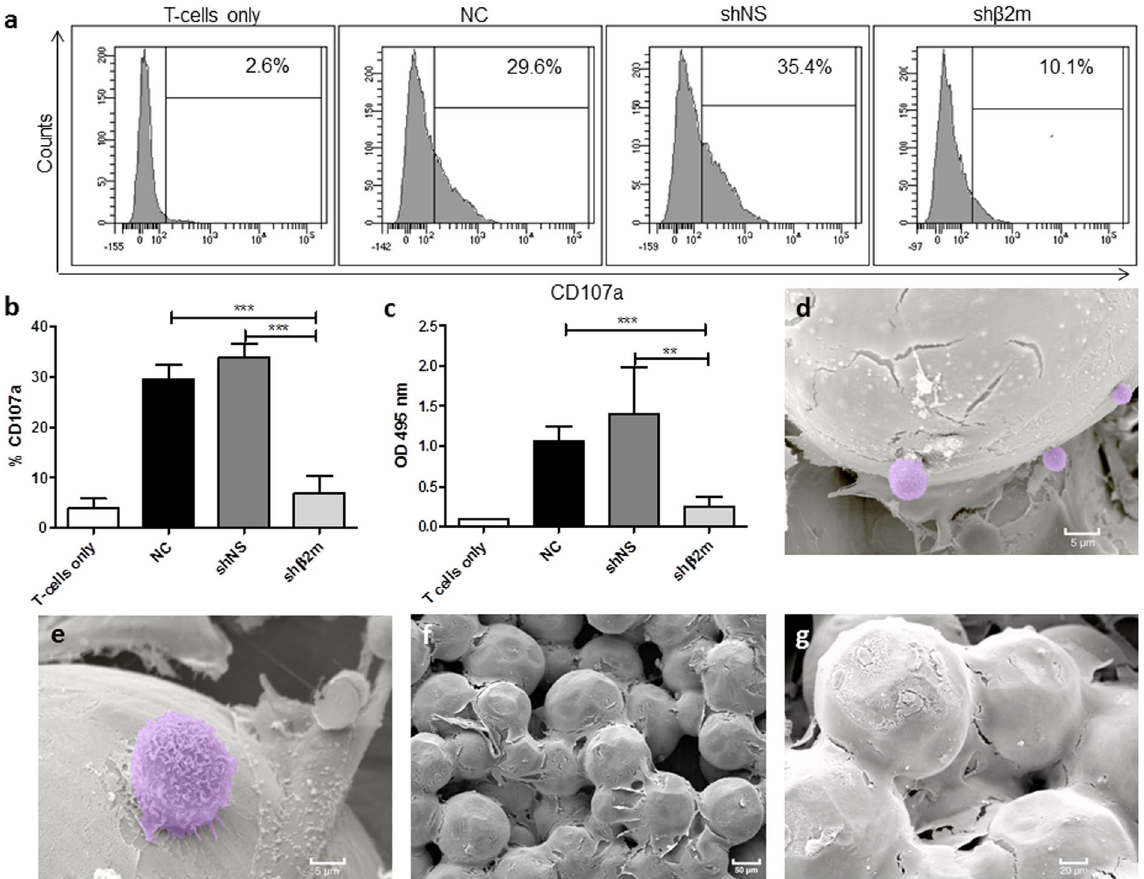
Figure 7. HLA class I silenced EC on SIC are protected against CD8 + T cell cytotoxicity. NC, shNS or sh β 2m ECs were incubated with CD8 + T cells; * p < 0.05; ** p < 0.01; *** p < 0.001. ( a ) Representative histograms of the frequency of CD107a expression show higher CD8 + T-cell degranulation after exposure to HLA expressing ECs in comparison to HLA class I-silenced ECs. ( b ) The graph displays mean values and standard deviations of CD107a expression frequencies (n = 5). ( c ) Similarly, in CD8 + T-cell cytotoxic assays, HLA class I- expressing EC cell lysis rates were significantly higher in comparison to HLA class I-silenced cells. The graph shows mean values and standard deviations of optical densities values indicating LDH activity released by ECs (n = 5). ( d , e ) SEM analysis of the T-cell cytotoxic assay on SIC indicated the adherence of primed CD8 + T-cells only to non- silenced endothelial cells. For better visualization, the CD8 + T-cells on the NC ECs were highlighted in purple, ( f and g ) SEM analysis of sh β 2m ECs on SIC revealed the absence of CD8 + T-cells on the cell